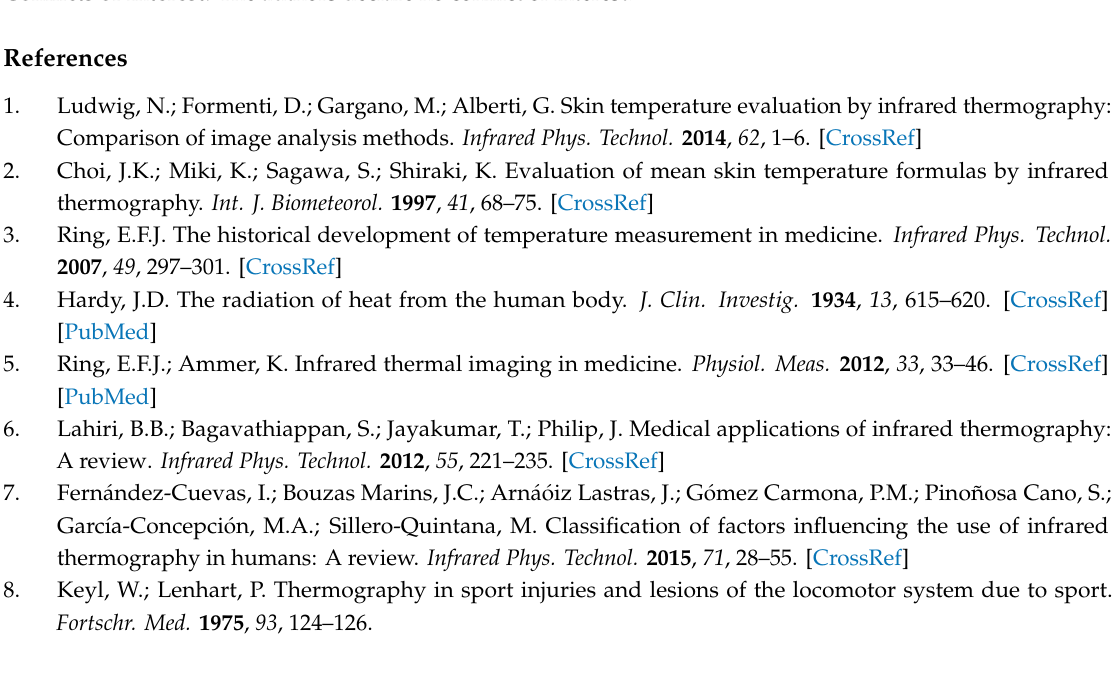
Figure S1: Definition of the ROIs for the single body parts, Figure S2: Temperature variations on the body parts for veteran athletes, Figure S3: Temperature variations on the body parts for national athletes, Figure S4: Temperature variations on the body parts for international athletes, Figure S5: Comparison between the temperature variation of the dominant and non-dominant part of the veteran athletes, Figure S6: Comparison between the temperature variation of the dominant and non-dominant part of the national athletes, Figure S7: Comparison between the temperature variation of the dominant and non-dominant part of the international athletes. Table S1: Temperature variations on the body parts for each athlete, Table S2: Temperature variations for the dominant, non-dominant and trunk of each